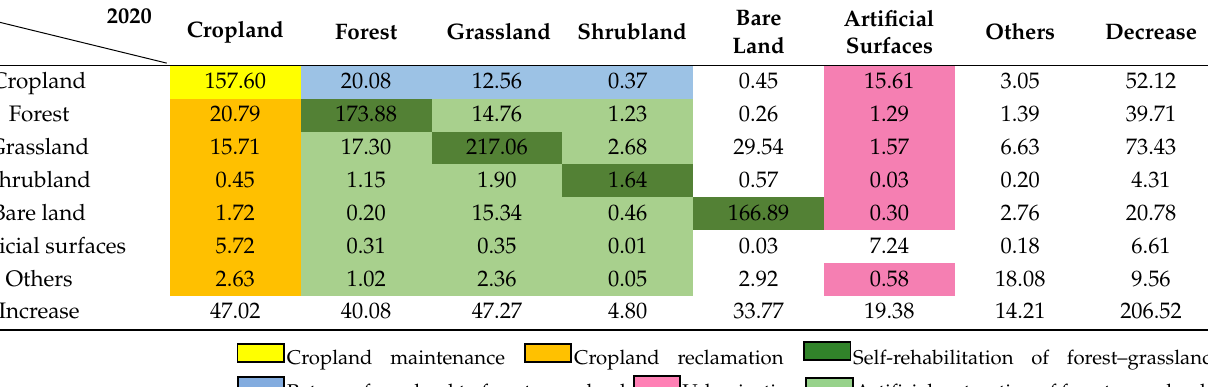
Urbanization Artificial restoration of